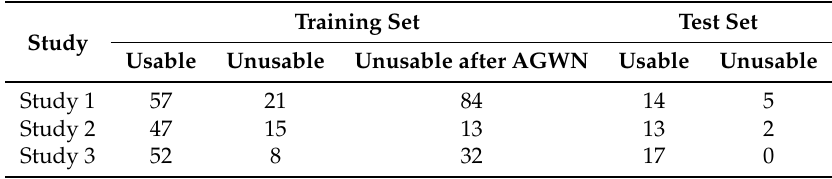
Table 2. Usable and Unusable Samples in Training and Test Score by